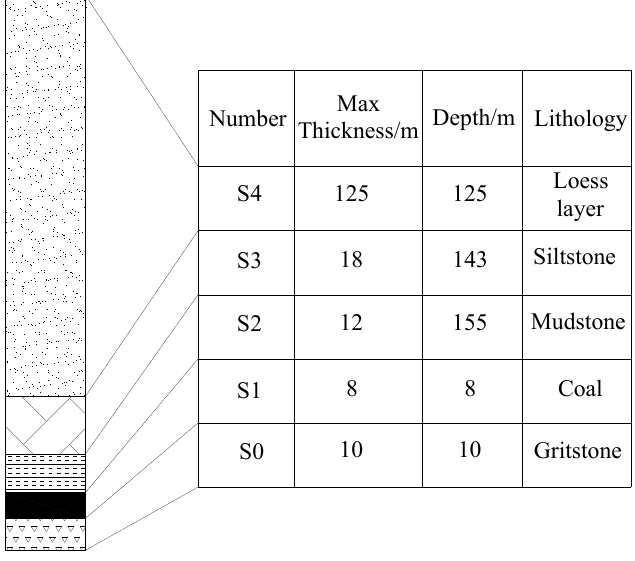
Figure 1. Simplified distribution of overlying strata above the working face.